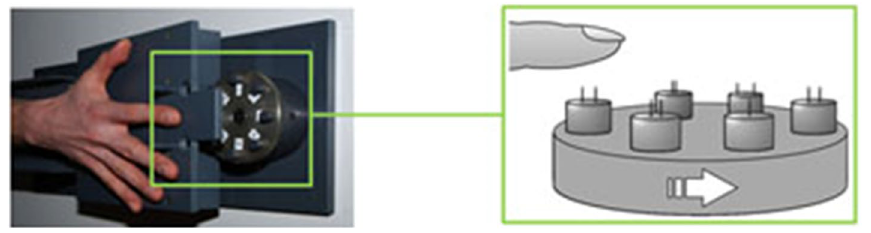
Figure 1. The two-point discrimination device used in the study. Seven different inter-pin distances (0.7– 2.5 mm) and 1 control pin (0 mm) are presented to the index finger in random order.